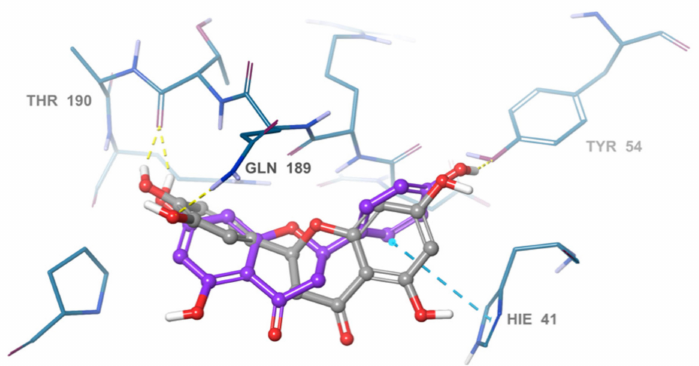
Figure 6. Overlay of eriodyctiol (grey), and naringenin (violet). in the SARS-COV-2 main protease active site.